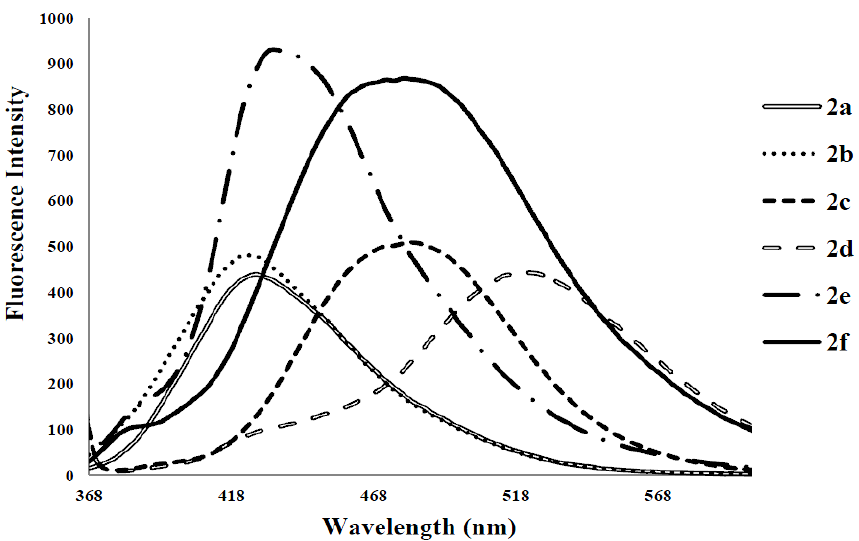
Figure 4. The fluorescence emission spectra of 2a – f ( λ 2.0 × 10 − 7 mol/L) at